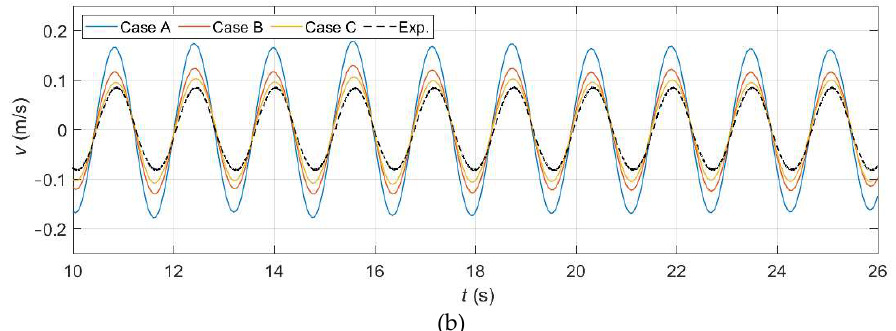
Figure 15. Numerical and experimental time series of the heave position ( a ) and velocity ( b ) for different phases with an open-loop system.